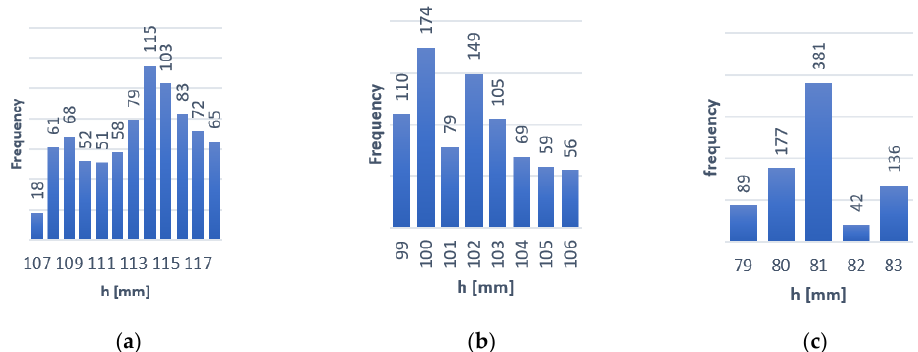
Figure 12. FUZZY Distribution, ( a ) compartment 1, ( b ) compartment 2, ( c ) compartment 3. The presented separation layer heights are set at the height of the overflow threshold and are the minimum values of the layer. This means that the controller the layer from falling below the set values. Any adjustments can only be made upwards.